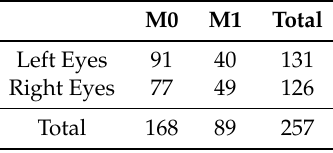
Table 1. Number of eyes in the interim dataset used for the analysis of overall retinal thickness. M0 M1 Total Left Eyes 91 131 257